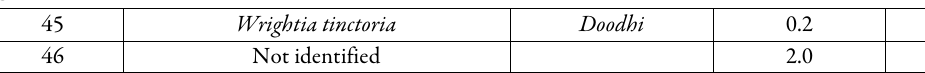
Table 5. Resident vultures’ nesting habits in central India Vulture species